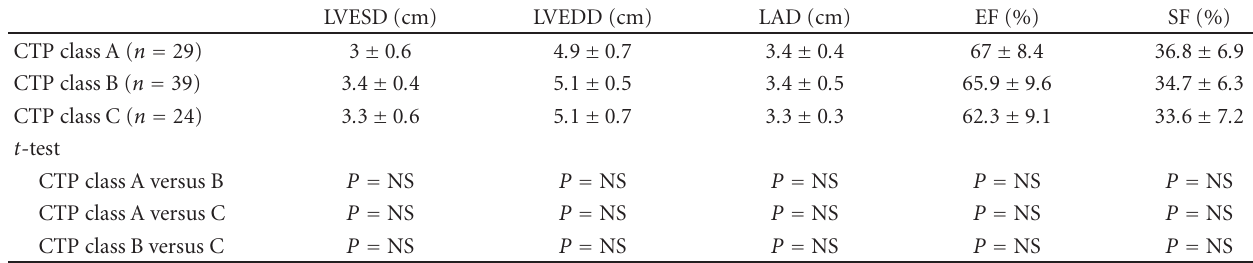
Table 1: Comparative assessment of echocardiographic measurements and left ventricular systolic performance parameters with regard to severity of liver disease.